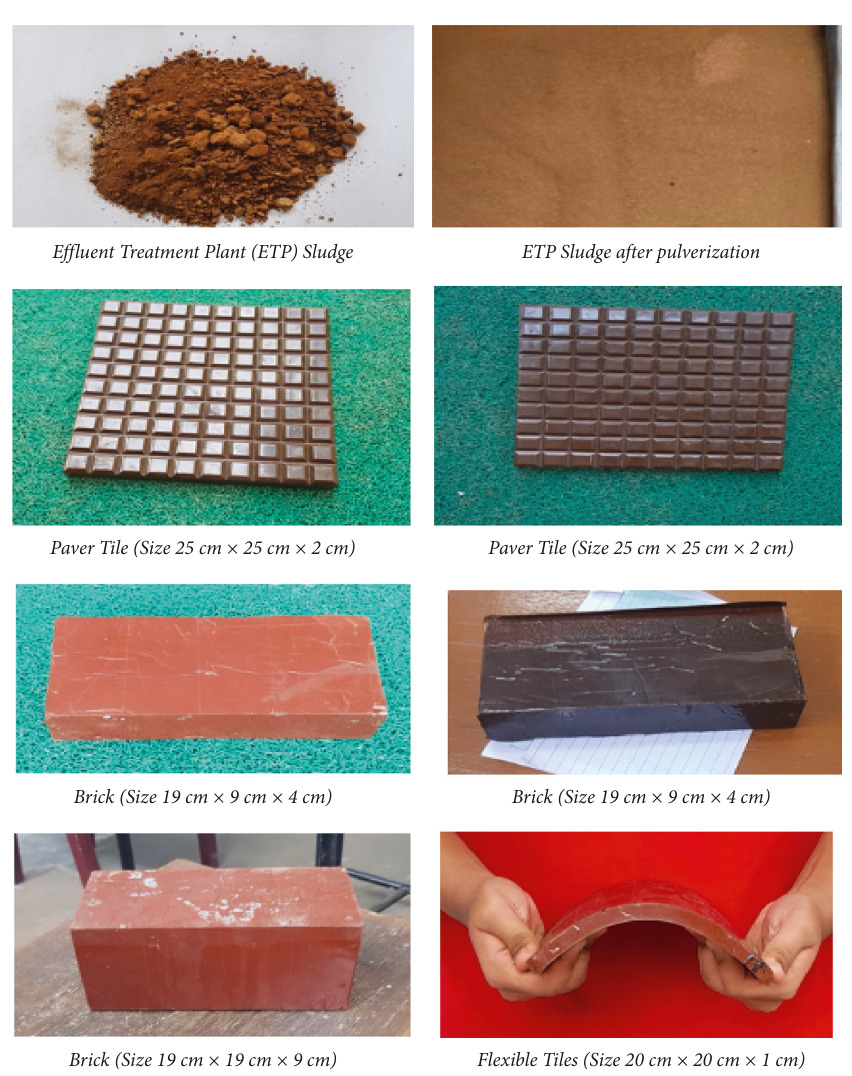
Figure 4: Polymer based Paver Tiles, Paver Blocks and